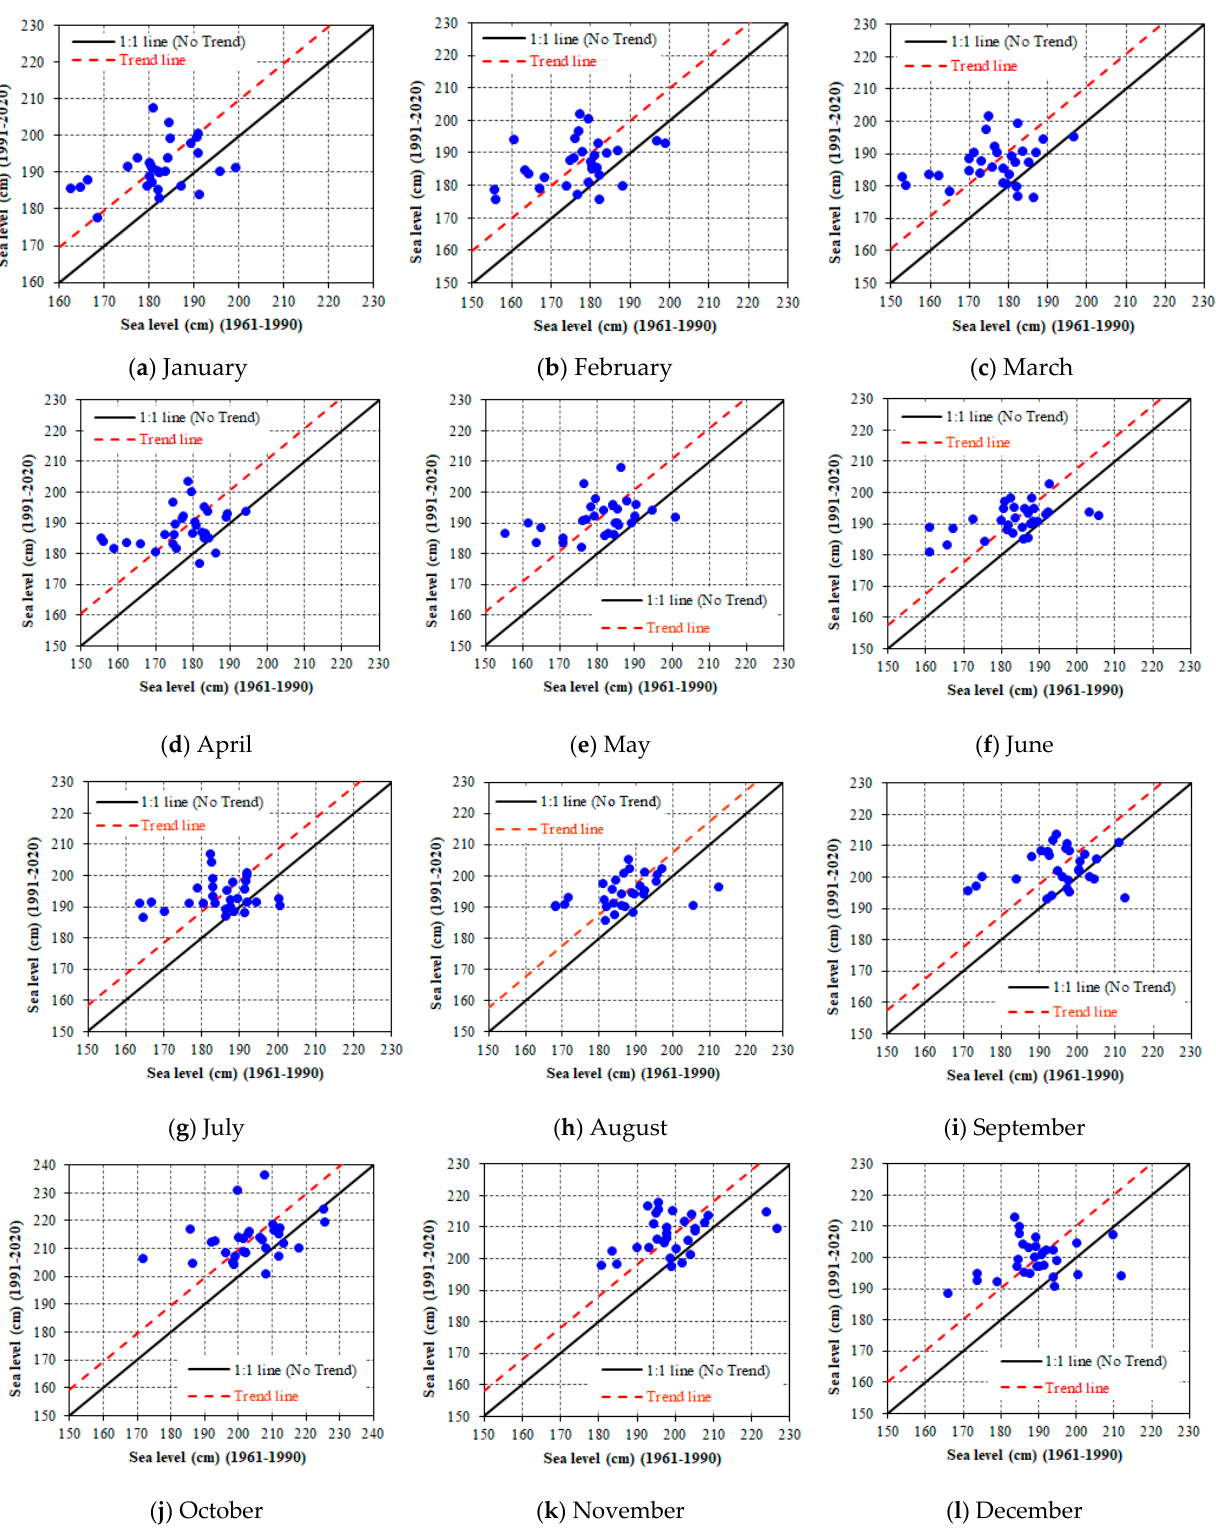
Figure 5. Results of the ITA on monthly sea level for the Hon Dau station (1961–2020). The results of the ITA method for the subperiod 1961–1980 also showed a significant increasing trend for all months, and with a high rate compared with the period 1961–2020: around 8.12–9.91 mm/year in early to middle winter months (November to January).